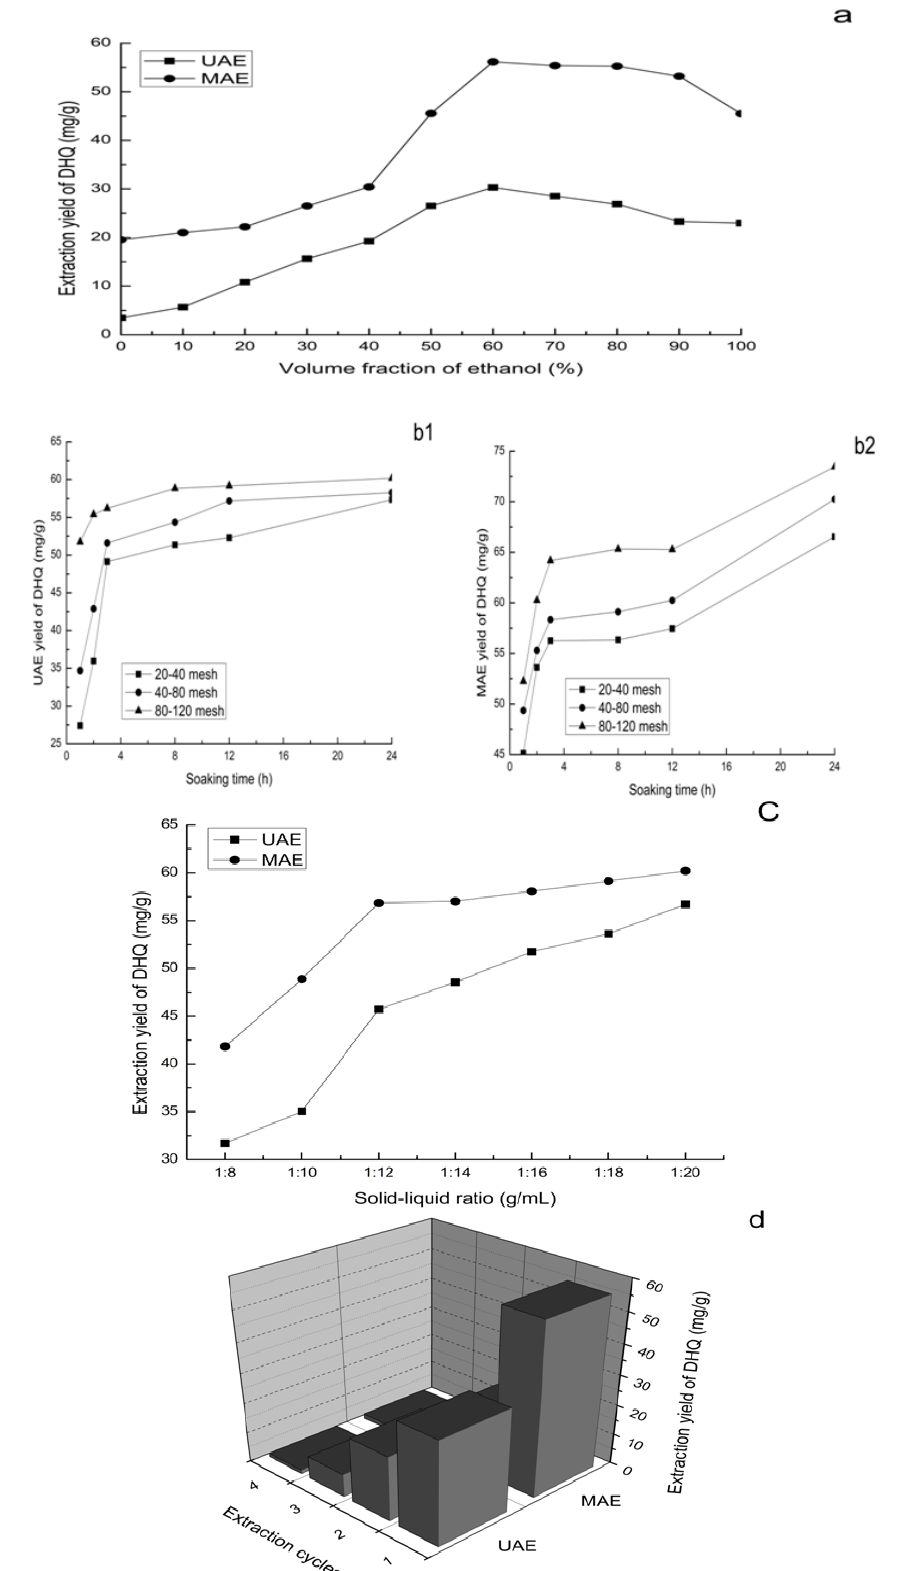
Figure 1. Effect of common factors on extraction yield of dihydroquercetin (DHQ). ( a ) Effect of volume fraction of ethanol on extraction yield; ( b ) Effect of soaking time on extraction yield; ( c ) Effect of solid-liquid ratio on extraction yield; ( d ) Effect of extraction cycles on extraction